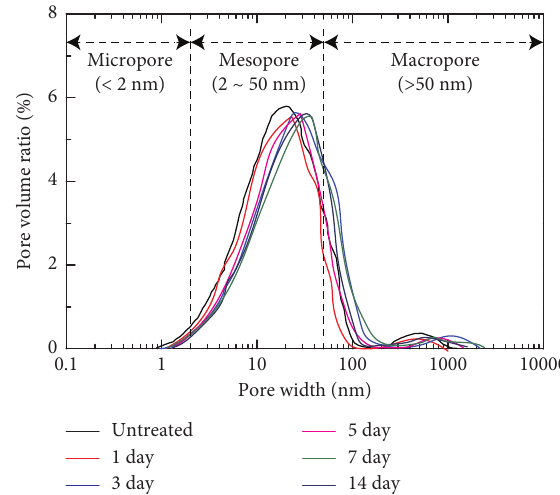
Figure 5: The pore widths evolution before and after CO